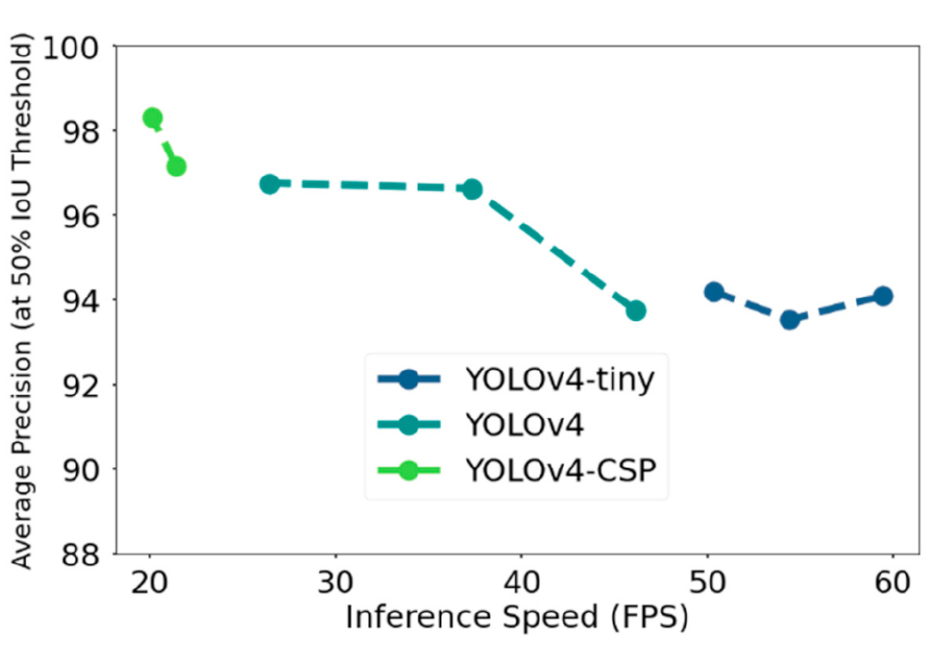
Figure 15. Comparison of the YOLOv4 models in terms of accuracy (in this case, Average Precision at 50% Intersection-over-Union threshold) and inference speed (frame per